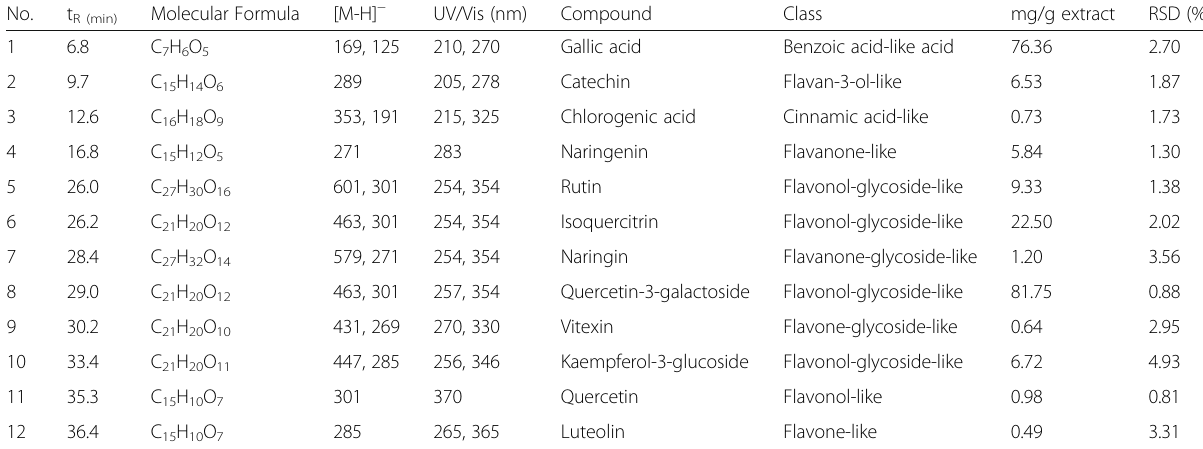
Table 2 HPLC-PDA/ESI-MS (negative ionization mode) polyphenolic fingerprint of Ficus vasta leaves extract No.